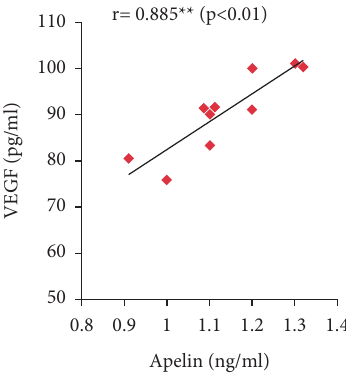
Figure 9: Correlation between serum apelin and VEGF in the PE group.